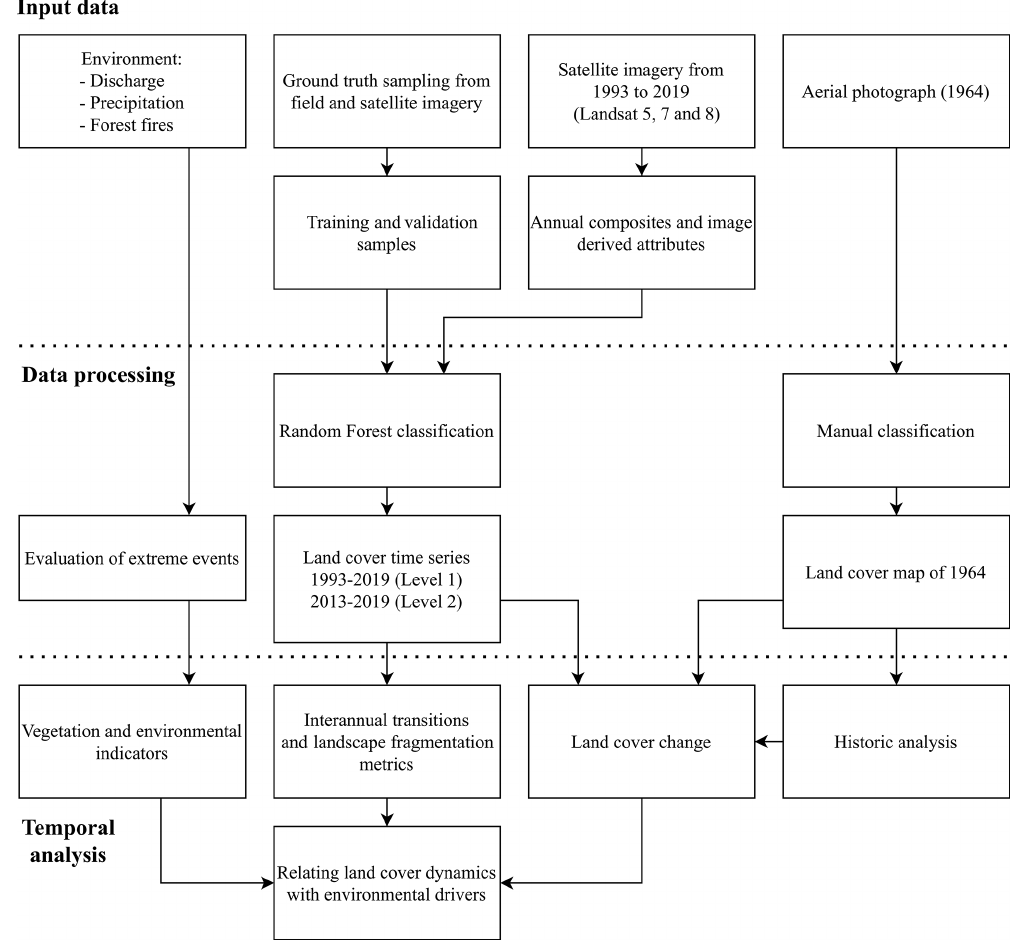
Figure 2. Flowchart showing steps from data sources to